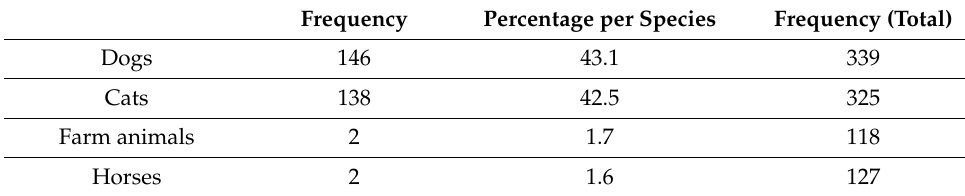
Table A9. Frequency and percentage of first-opinion practice per species.